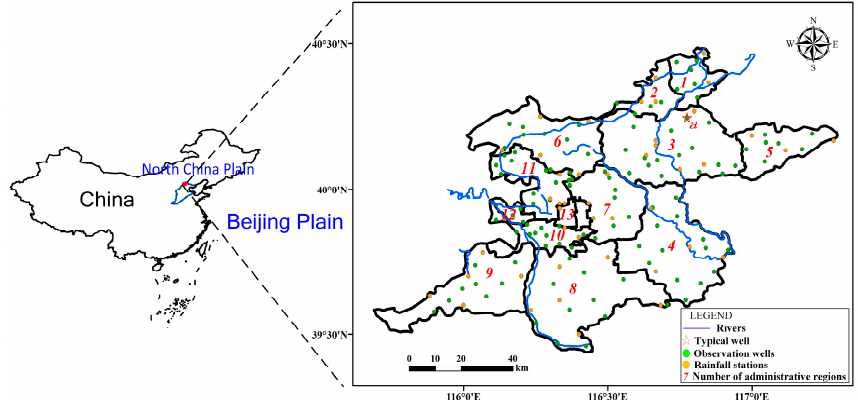
Figure 4. Schematic figures of the study area.